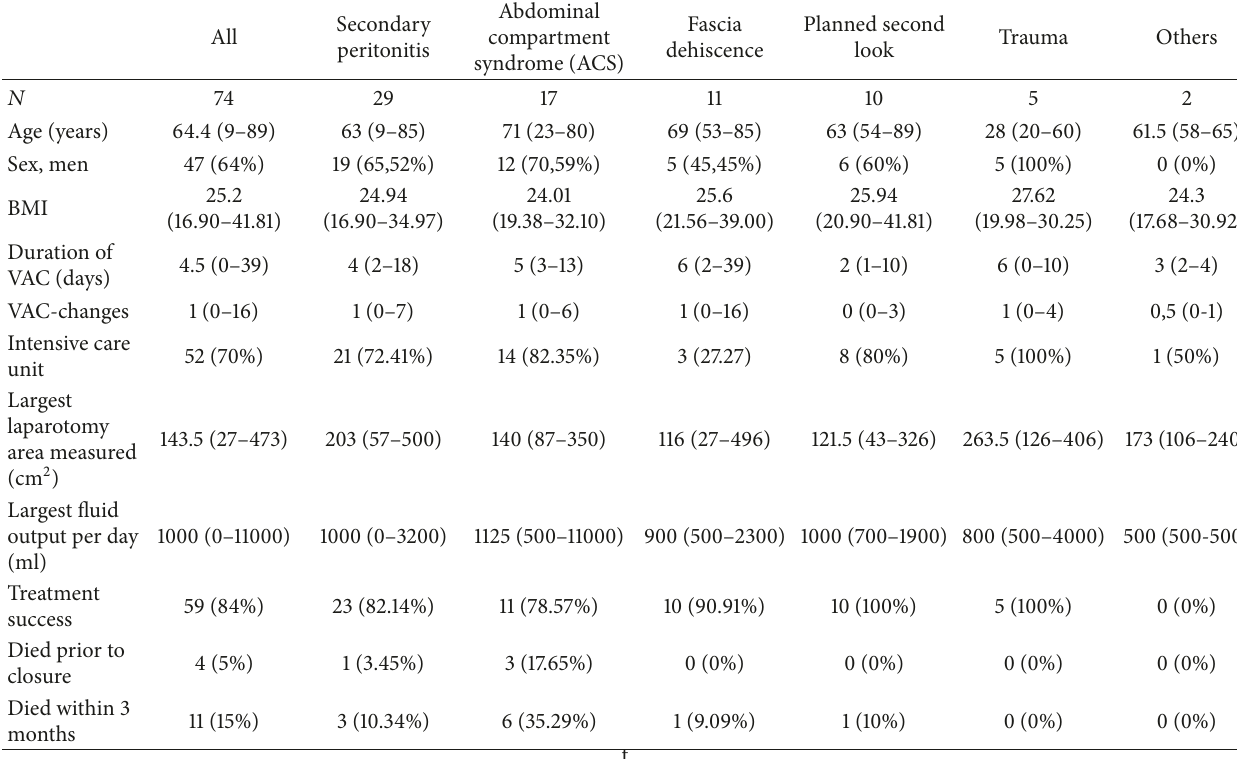
Table 1: Patient background data and data regarding VAC treatments. Unless otherwise stated, the results are given as median (range) or number 𝑁 (%).